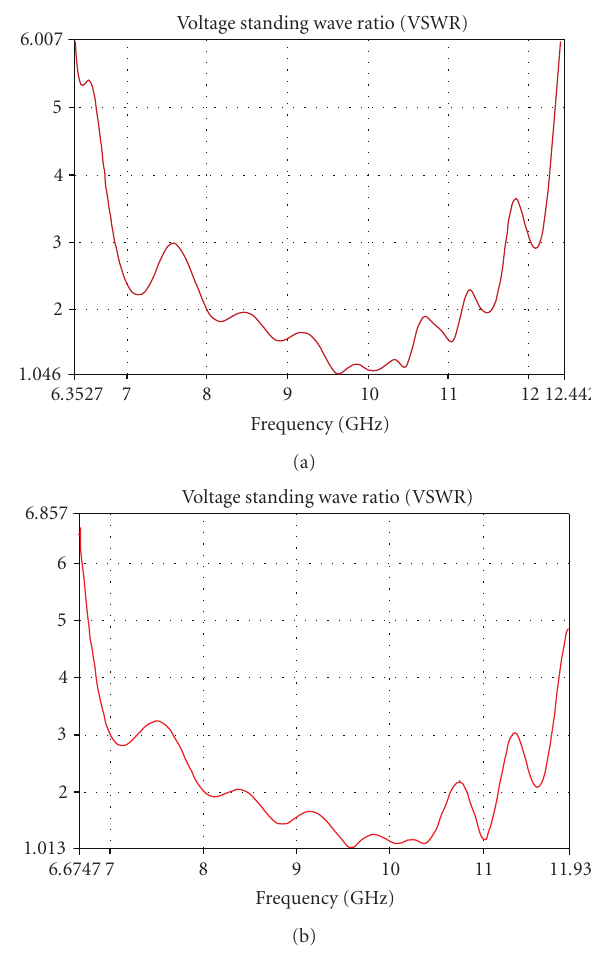
Figure 8: (a) Simulated VSWR of LWA Type II. (b) Simulated VSWR of LWA Type